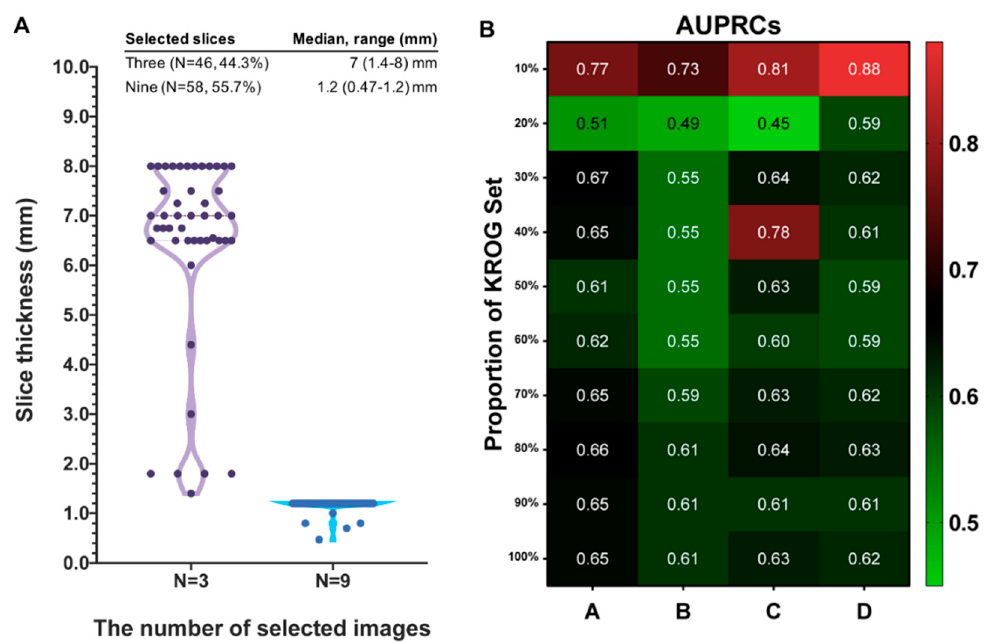
Figure 2. ( A ) Distribution of slice thickness between cases of the selection of 3 images for triplication and those of the selection of 9 images. ( B ) Heatmap showing the pattern of area under the precision-recall curve (AUPRC) according to the proportion of the “KROG” set with each model parameters: parameter “A” defined as the scaler range with [0,1] and epoch number as 20, parameter “B” as [0,1] and 25, parameter “C” as [ − 1.5,1.5] and 20, and parameter “D” as [ − 1.5,1.5] and 25. Abbreviations: CNN, convolutional neural network; LSTM, long-short term memory.